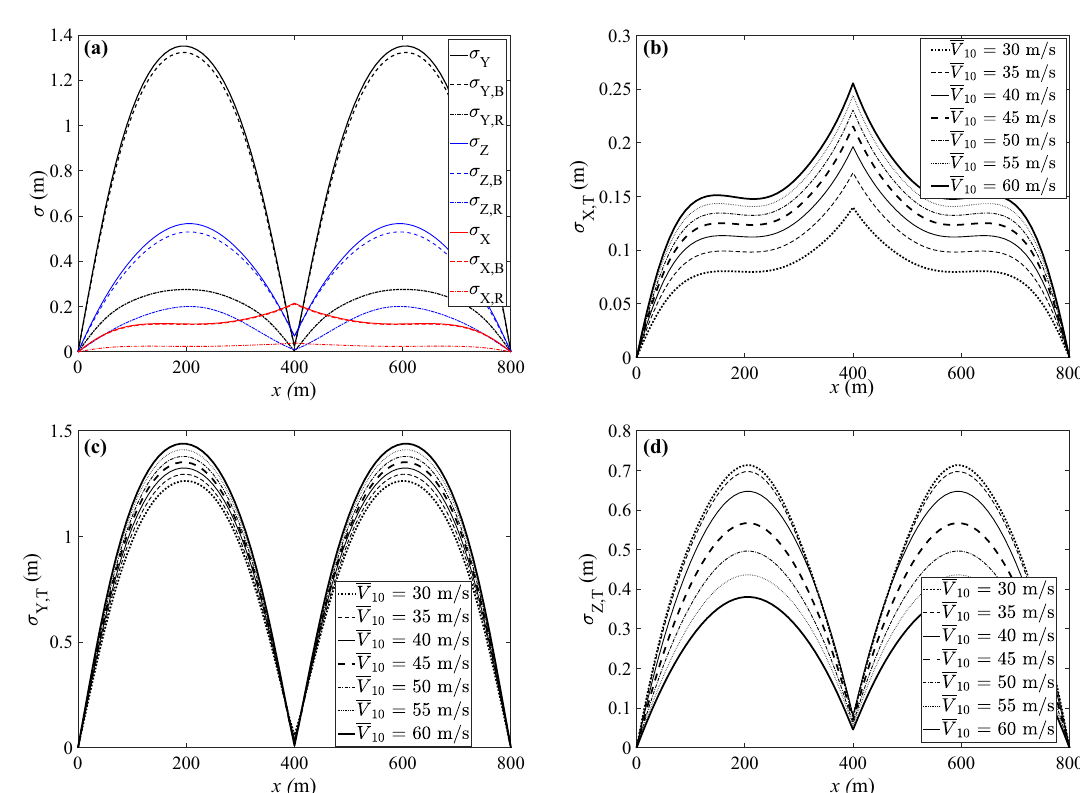
Figure 12. Comparison of standard deviations of displacement responses: ( a ) V 10 = 45 m/s; ( b ) longitudinal displacement; ( c ) alongwind displacement; ( d ) crosswind